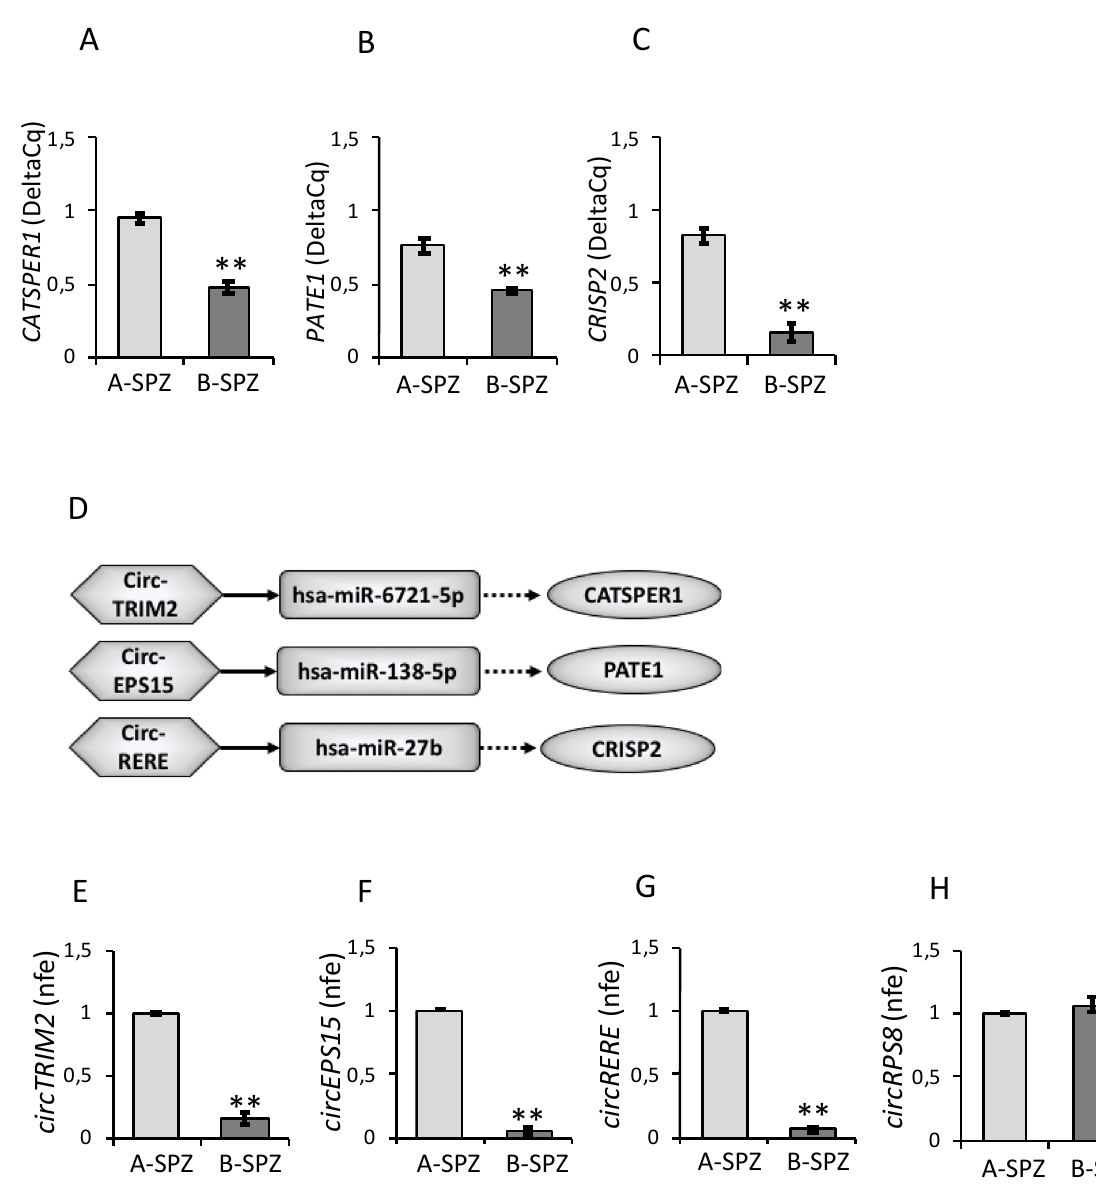
Figure 2. Expression of CATSPER1 , PATE1 , CRISP2 and circRNAs in Asthenozoospermic Sperm . ( A – C ) Differential expression analysis of mRNAs between A-spermatozoa and B-spermatozoa (A-SPZ; B-SPZ) collected from asthenozoospermic patients by qRT-PCR. ( A ) CATSPER1 , ( B ) PATE1 and ( C ) CRISP2 were normalized by using GAPDH as reference. Data are expressed as normalized quantification cycle for PCR (Delta-Cq) and reported as mean value ± S.E.M; **: p < 0.01. ( D ) Functional clustering of circRNAs upregulated in asthenozoospermic A-spermatozoa identified by the microarray approach [41]. Three circRNAs tether a group of miRNAs involved in CATSPER1 , PATE1 and CRISP2 mRNA regulation. Networks were built using Cytoscape. Hexagonal and rectangular symbols represent circRNAs and miRNAs, respec- tively, while the elliptic symbol represents mRNA target. The arrow indicates the tethering activity of circRNAs towards miRNAs, while the dotted arrow indicates the inhibiting activity of miRNAs towards mRNAs. ( E – H ) Differential expression analysis of circRNAs between A-spermatozoa and B-spermatozoa collected from asthenozoospermic patients by qRT-PCR. ( E ) circTRIM2, ( F ) circEPS15, ( G ) circRERE ( H ) and circRPS8 were normalized by using GAPDH as reference and expressed as normalized fold expression (nfe). All data are reported as mean value ± S.E.M; **: p < 0.01.